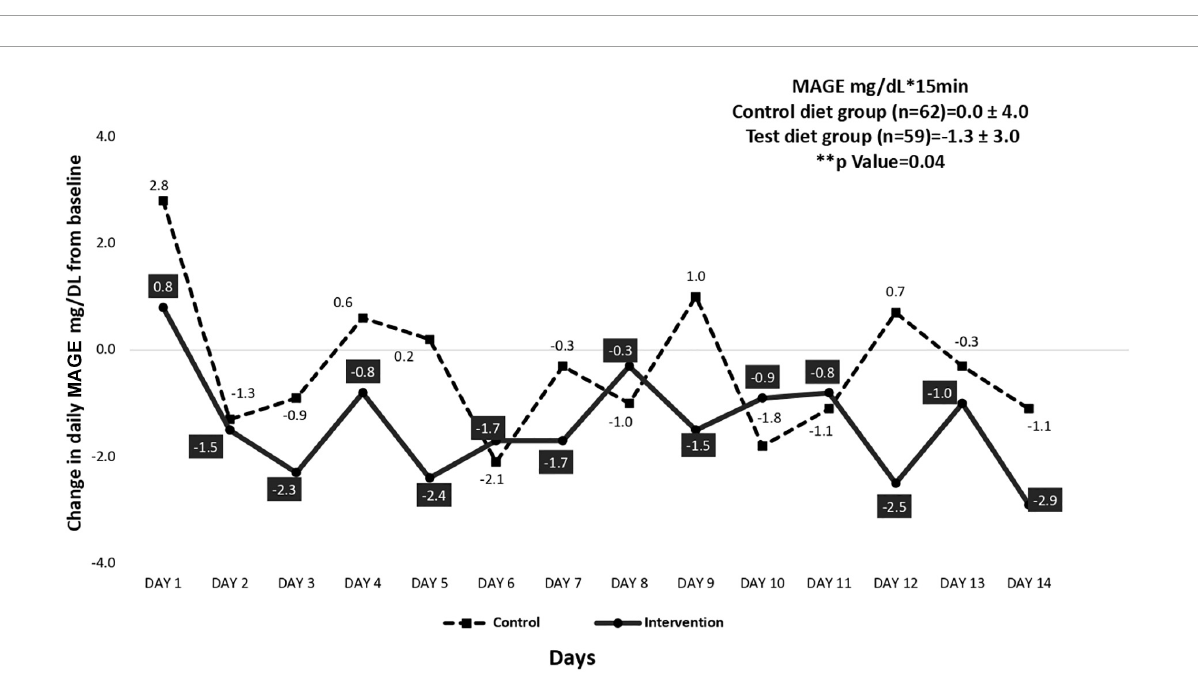
FIGURE2 Mean change in mean amplitude glycemic excursions (MAGE) assessed by continuous glucose monitoring (CGM) system for control and intervention group participants from baseline ( n =